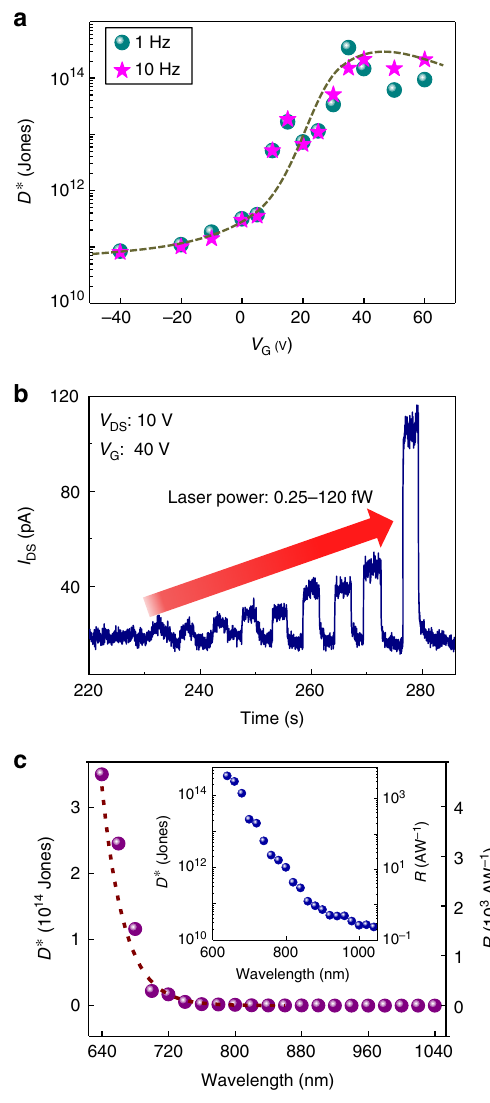
Fig. 3 Ultrahigh sensitivity and spectrum. a Speci fi c detectivity D (cid:1) as a function of back-gate voltage at V DS of 10 V and optical modulated frequency of 1 Hz and 10 Hz, the dash line is a guide to the eye. b Time dependence of photo-response with increasing irradiance showing a direct measurement of laser power as low as 0.25 fW. c Spectral detectivity and responsivity under irradiance of 1 nW cm − 2 and at V DS of 10 V and V G of 35 V, the insert is the spectrum with log scale for y -axis showing the extended spectrum to near-infrared region (1000 nm) with high